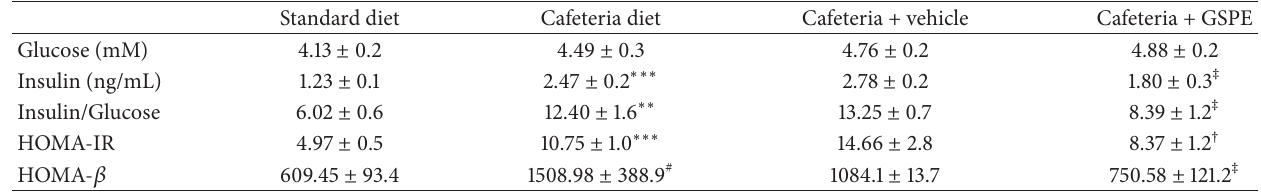
Table 1: Effects of the cafeteria diet and GSPE treatment on plasmatic glucose and insulin levels, HOMA-IR and HOMA- 𝛽 index. ∗∗ 𝑃 ≤ 0.01, ∗∗∗ 𝑃 ≤